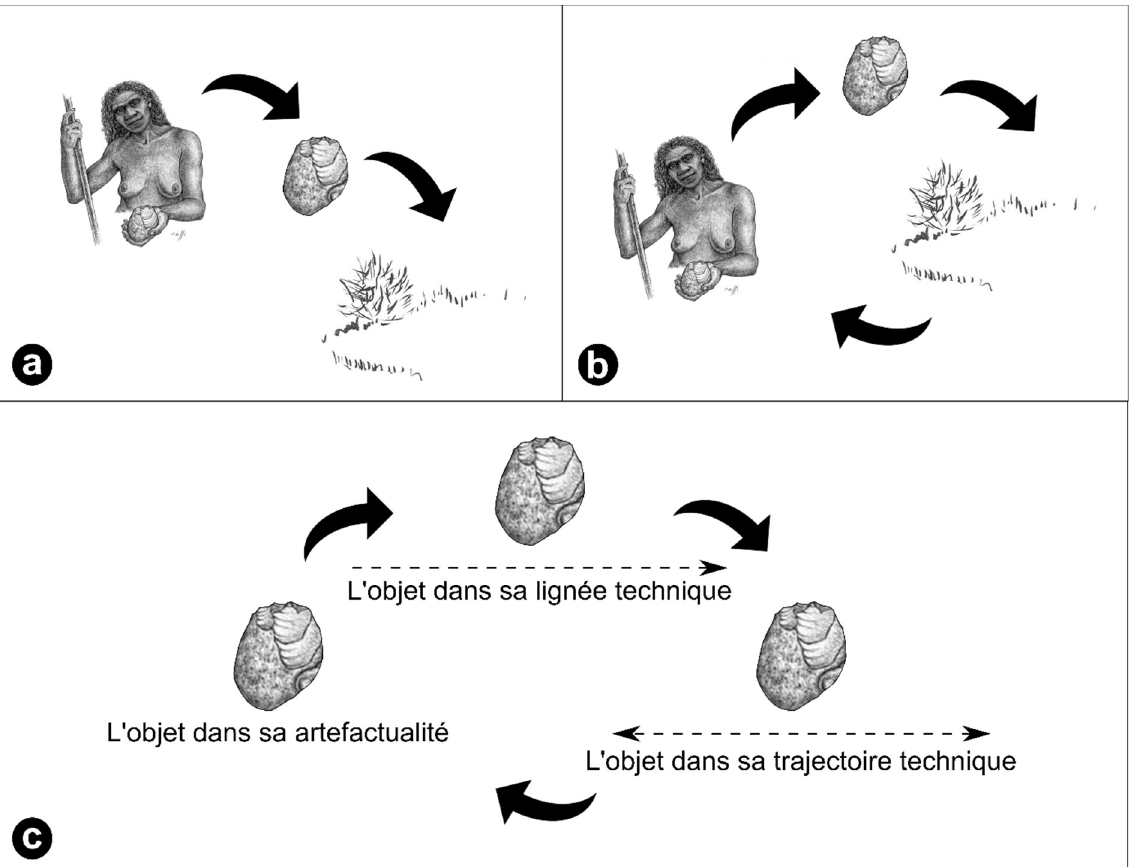
Figure 1. Différents types de relations entre les humains, les artefacts et l'environnement: (a) le cas habituel des épistémologies en anthropologie qui considèrent l'être humain comme le maître de la nature. Dans cette conception, l’objet n'est qu'un intermédiaire entre l'être humain et l'environnement. (b) Le cas le plus récent de certaines épistémologies en anthropologie qui considèrent une relation symétrique entre l'être humain, l’objet et l'environnement. (c) Le cas de l'épistémologie du réalisme des relations, proposé dans cet article. En préhistoire, en n'ayant pas d'individus vivants, l’objet entre dans une relation symétrique avec sa lignée technique et avec